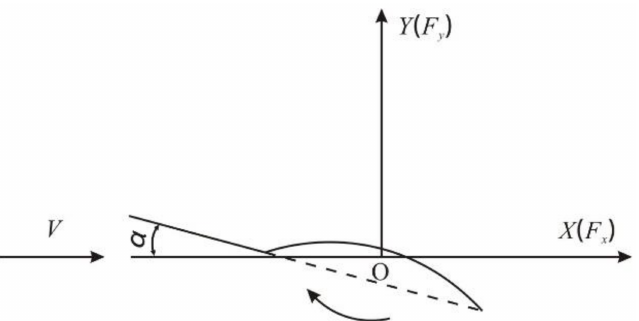
Figure 4. Parameter definitions of the test model in the wind tunnel. F y : lift; F x : drag; V : wind speed; α : angle of